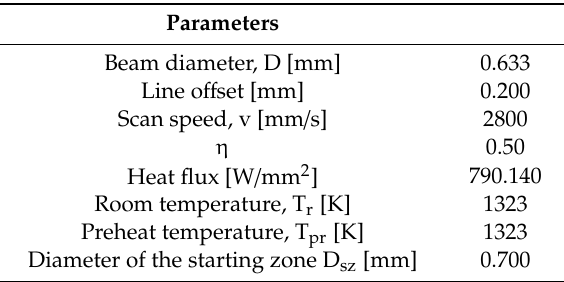
Table 1. Simulation parameters for both analyses.